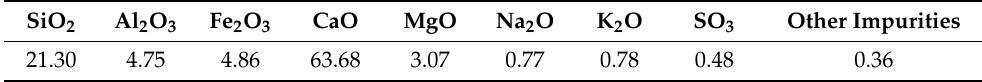
Table 2. Mass fraction content of CEM I 52.5 N, % [19].